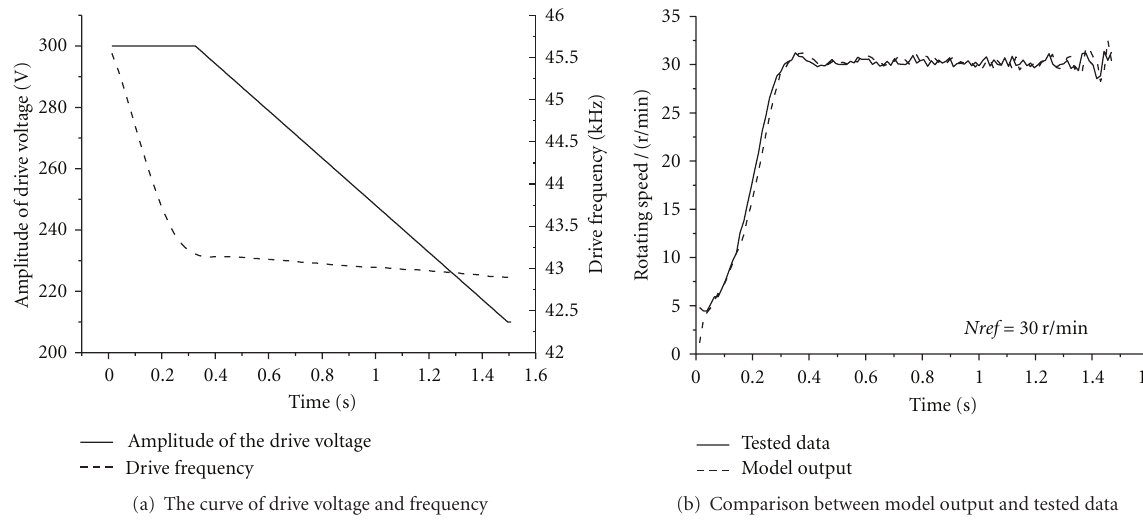
Figure 10: Step response comparison between model output and tested data ( Nre f = 30 r/min, no load).